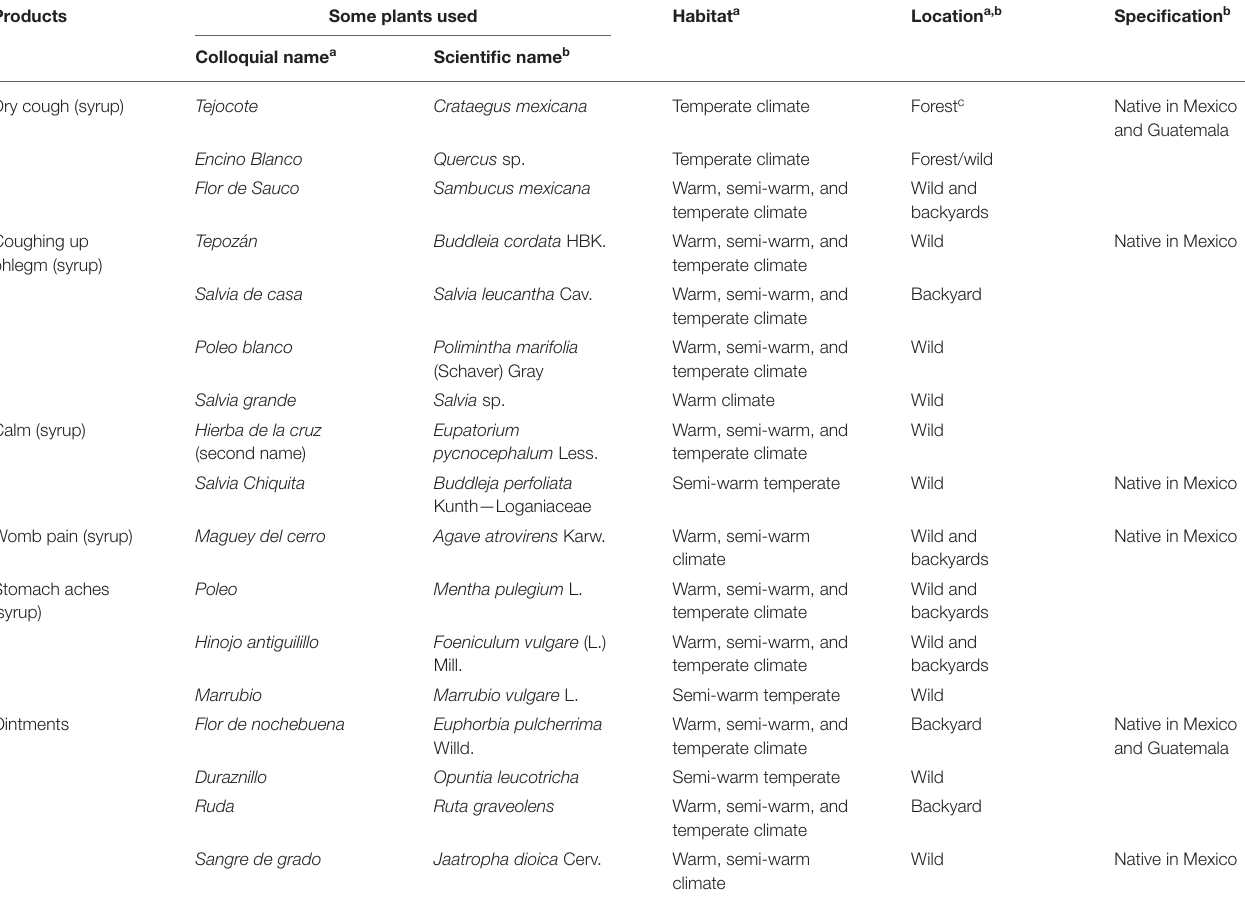
TABLE 4 | Some medicinal plants used by